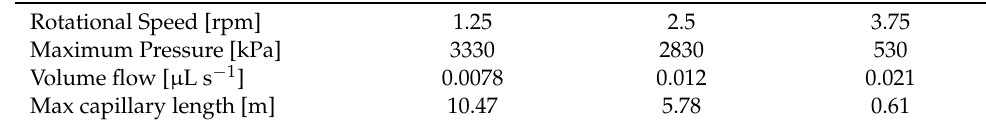
Table 1. Maximum capillary length for three operating conditions.